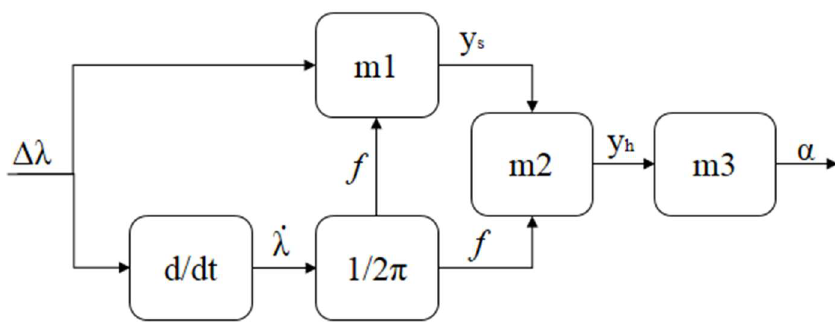
Figure 2. Block diagram of the sensitivity compensation (block m1), hysteresis compensation (block m2) and the correlation equation that results in the angle output (block m3).